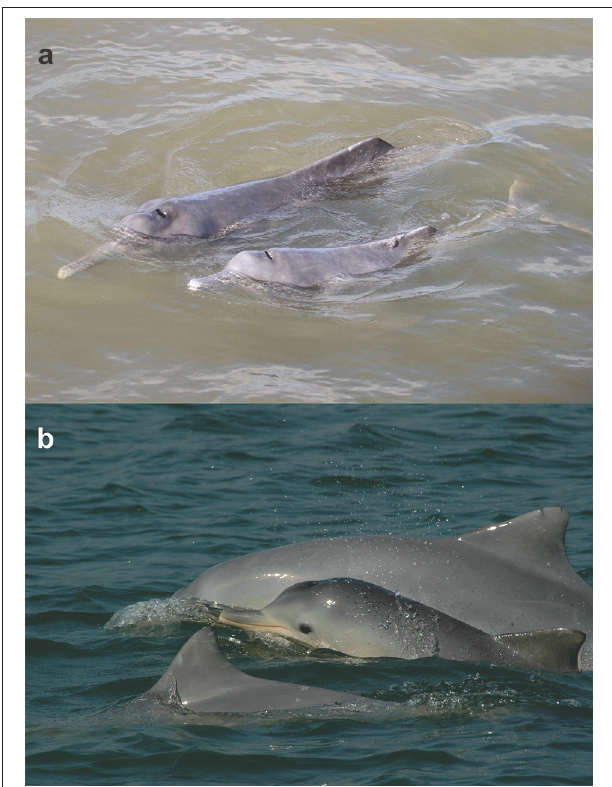
FIGURE 3 | (A) Mother and calf boto ( Inia spp.) sighted off Mocajuba, Tocantins River, Pará, Brazil; these may be “Araguaian botos,” Inia araguaiaensis which has been proposed as a new species’ ( Siciliano et al., 2016 ) and (B) a group of Guiana dolphins ( Sotalia guianensis ). Photos by PH Ott and MCO Santos,